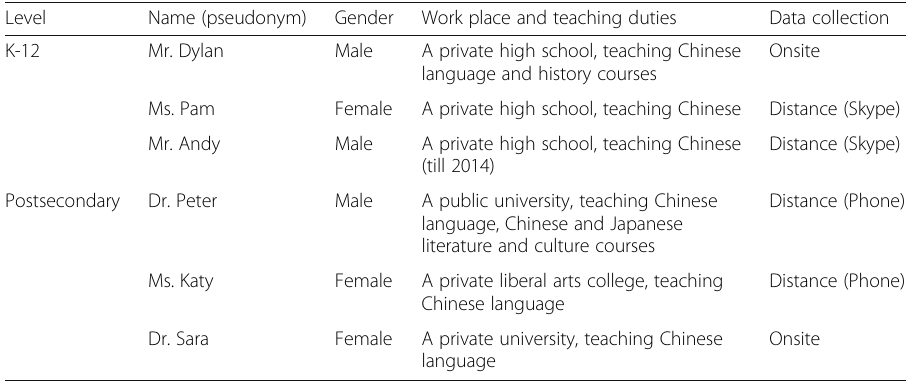
Table 1 Summary of the information on the participants and data collection